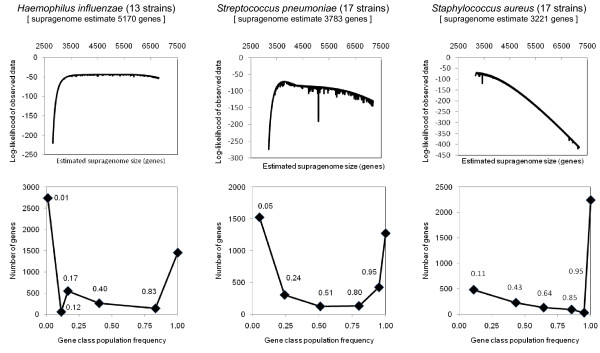
Finite supragenome model results using (K = 6) variable population gene frequency classes. In our previous supragenome analyses carried out with Haemophilus influenzae and Streptococcus pneumoniae we used a version of the finite supragenome model that required fixed population gene frequency classes. This model has been updated to make the optimization function (the log-likelihood of the observed sample gene frequency histogram, i.e., the observed gene frequency class distribution among the |S| strains examined) dependent on the values of the population gene frequency vector (μ) as well as the values of the corresponding mixture coefficient vector (π, for the probability that a gene in a supragenome will be represented in one of the K classes of population gene frequencies). For a given species, the bottom graph plots the values of the vector μ against the product of the estimate of supragenome size and the values of the vector π, all obtained at the maximization of the log-likelihood function.